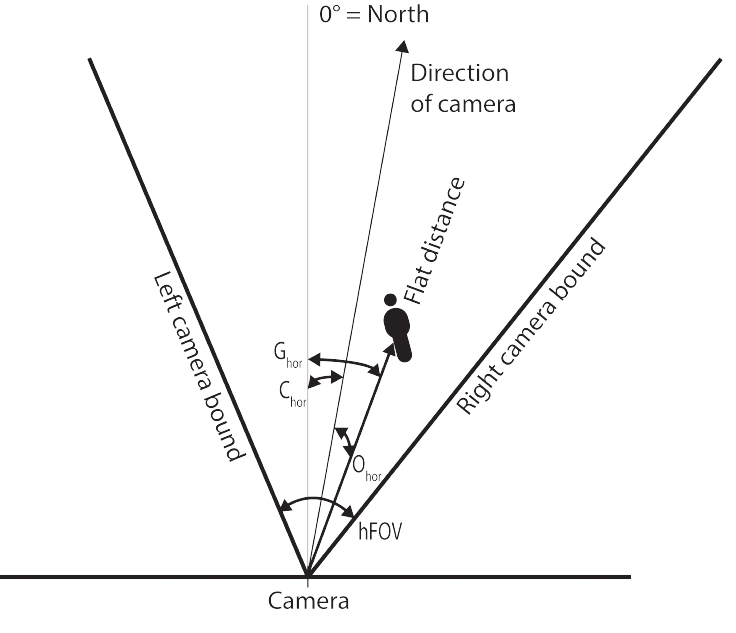
Figure 4. Horizontal